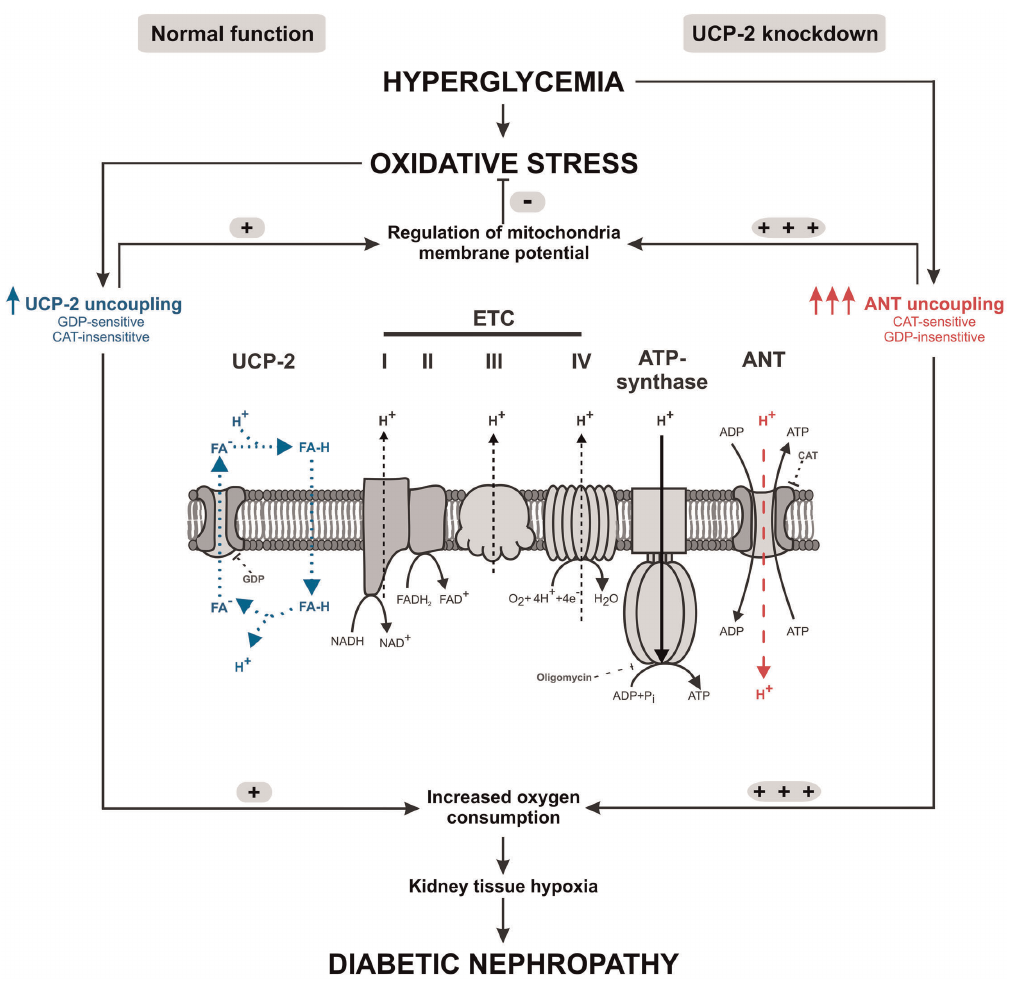
Figure 10. Summary of proposed mechanisms. Pathways highlighted in blue denote uncoupling via UCP-2; pathways highlighted in red denote uncoupling via ANT. ANT – adenosine nucleotide transporter, CAT – carboxyatractylate, ETC – electron transport chain, FA 2 – charged fatty acid, FA-H – uncharged fatty acid, GDP – guanosine diphosphate, UCP-2 – uncoupling protein 2.